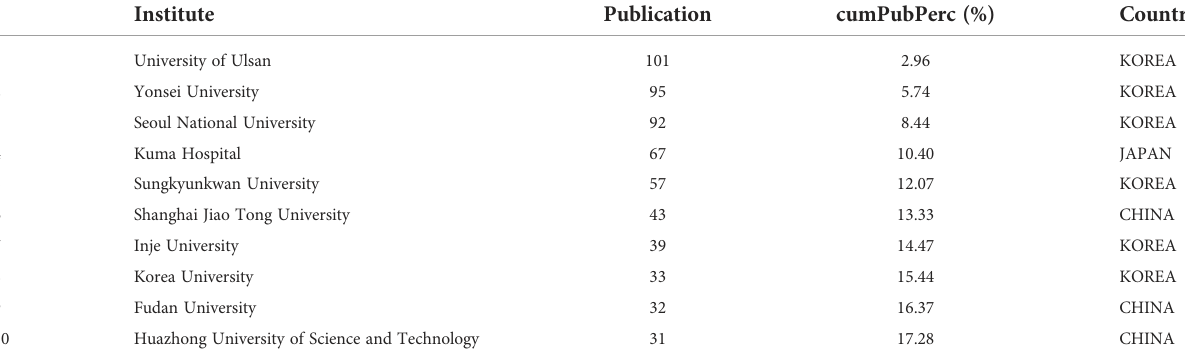
TABLE 2 The top 10 most productive institutions within PTMC research from 2000 to 2021 cumPubPerc= Cumulative publication percentage.